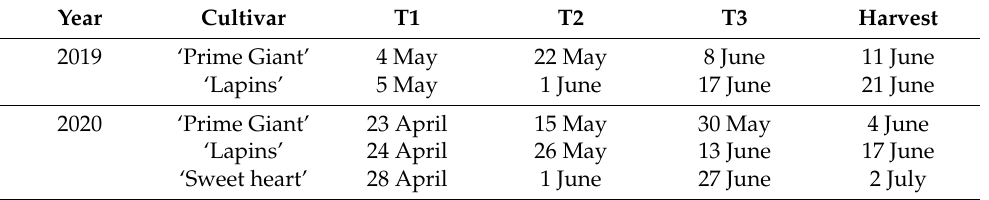
Table 1. Dates for treatments (T1, T2 and T3) and harvest date in the 2019 and 2020